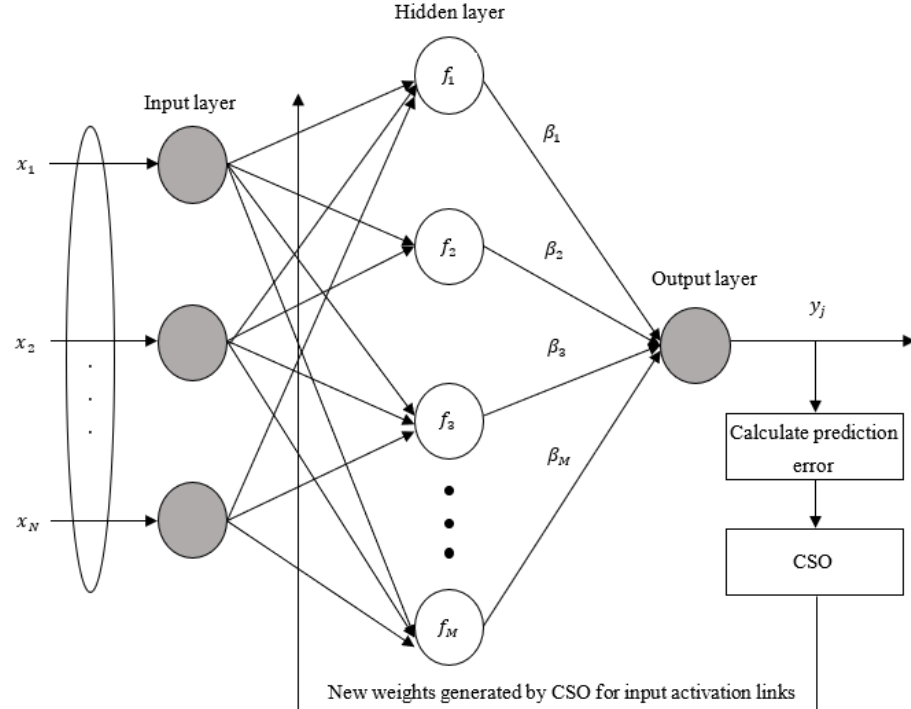
Figure 1. Architecture of ELM-CSO